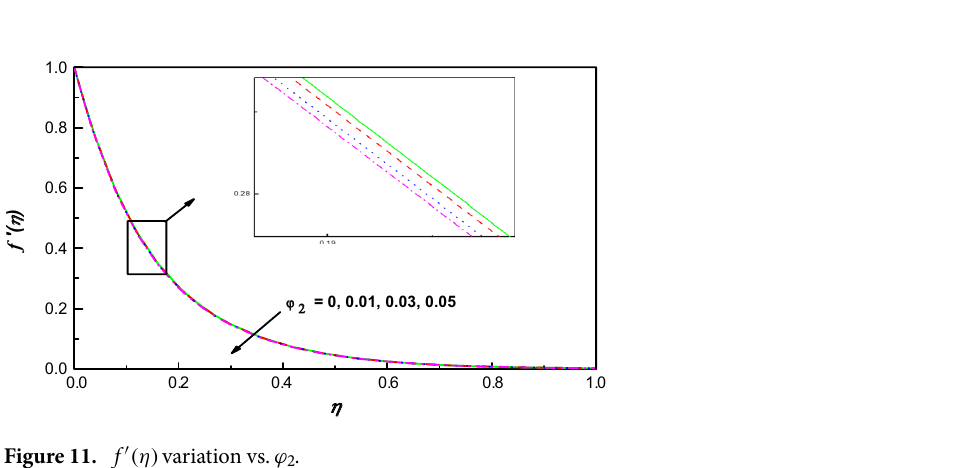
Figure 11. f ′ (η) variation vs. ϕ 2